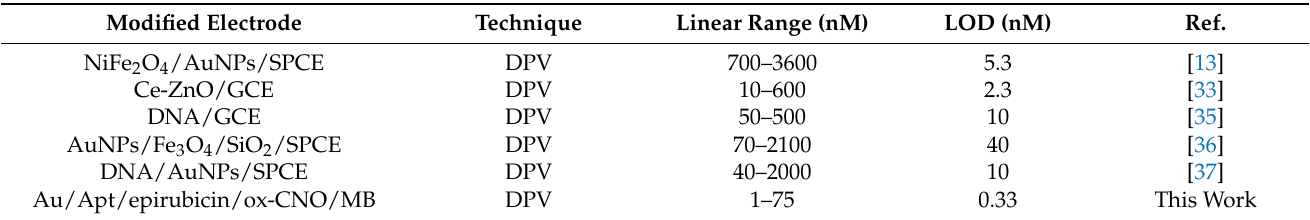
Table 1. The performance comparison of developed sensors for the epirubicin measurement.